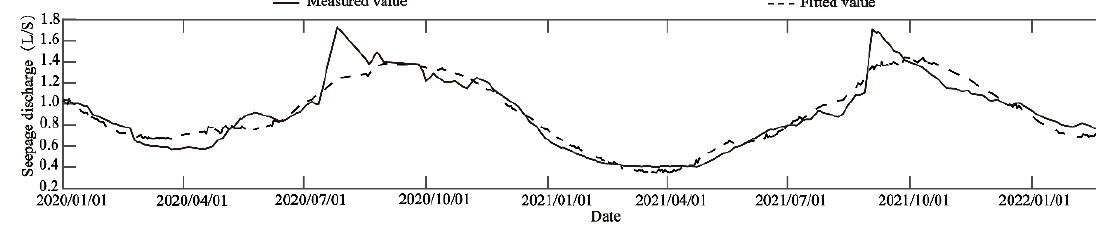
Figure 5. Fitting process line of seepage discharge at measuring point WE01XFG.